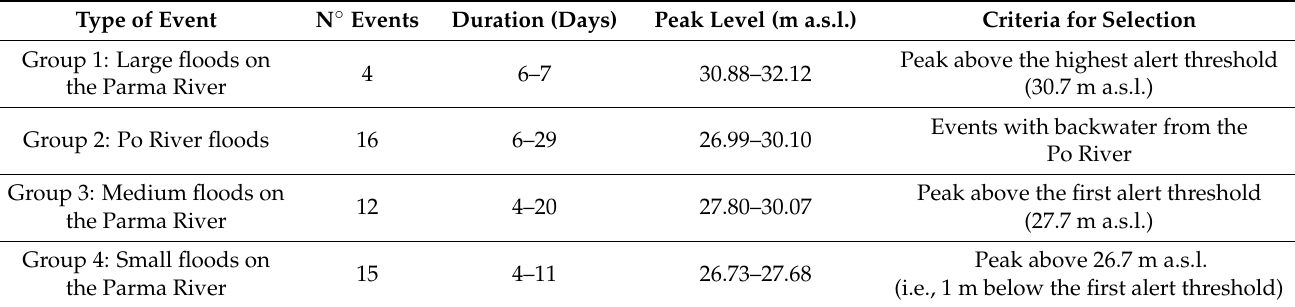
Table 1. Groups of flood events considered in this